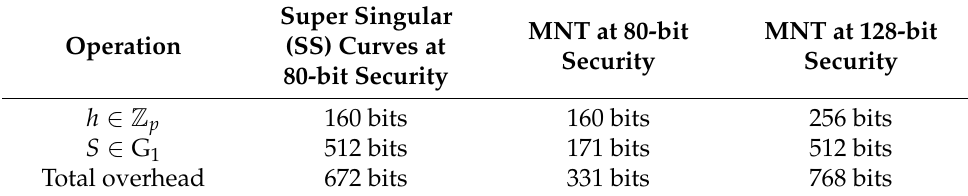
Table 2. Signature operation communication